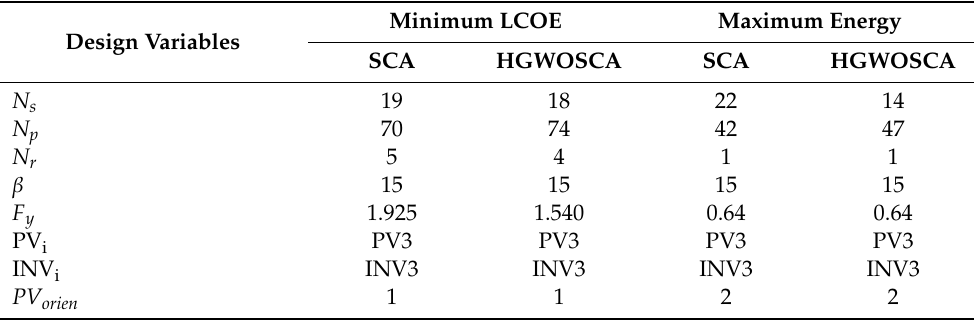
Table 9. Optimal design variables using hourly measurement data.